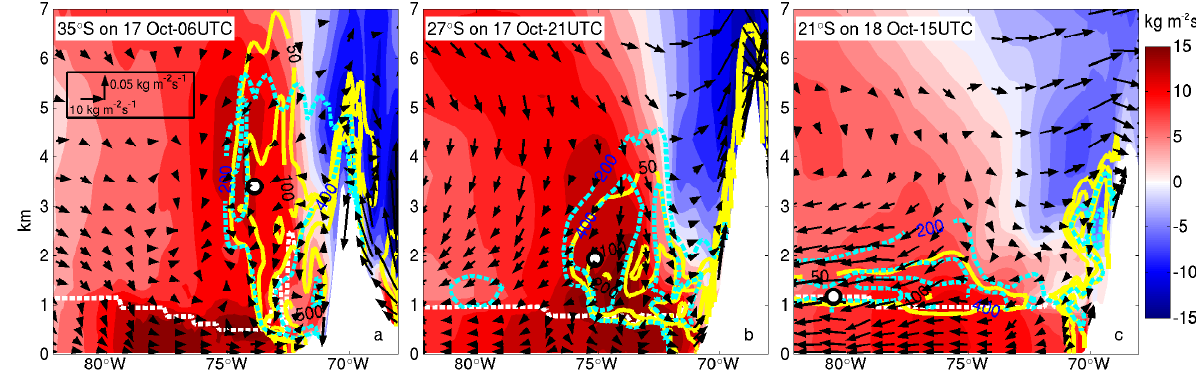
Fig. 14. Same as left column of Fig. 13 but for second half of the WRF-Chem 3-D trajectory (circle markers in Fig. 12) described in Sect. 4.4 as it advects northwest and subsides towards the boundary layer.